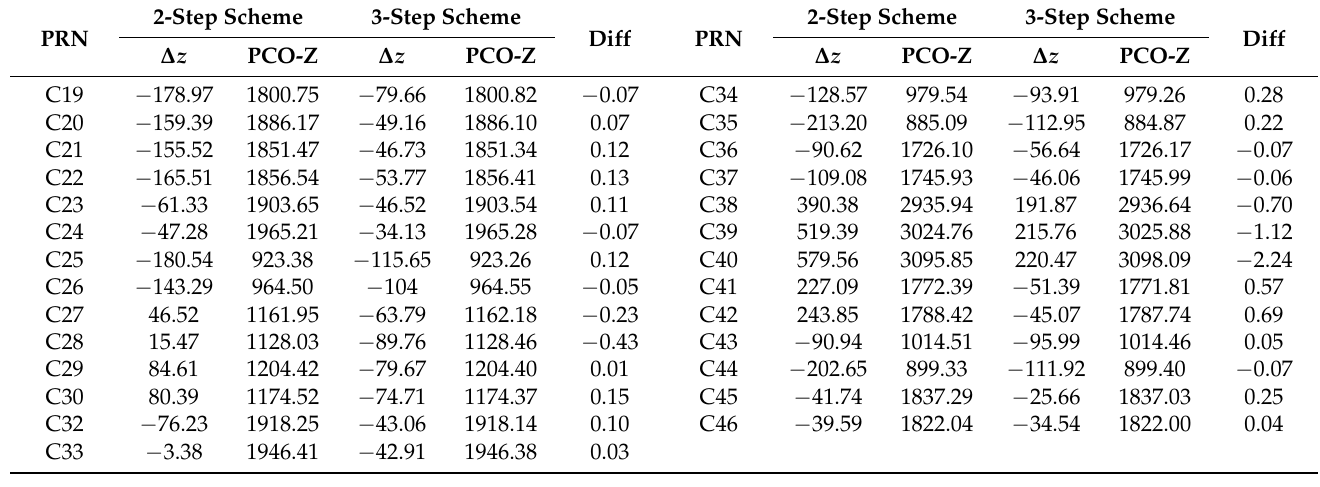
Table 3. The ∆ z and PCO-Z of both schemes, and the difference between the two sets of PCO-Zs, the unit is mm.